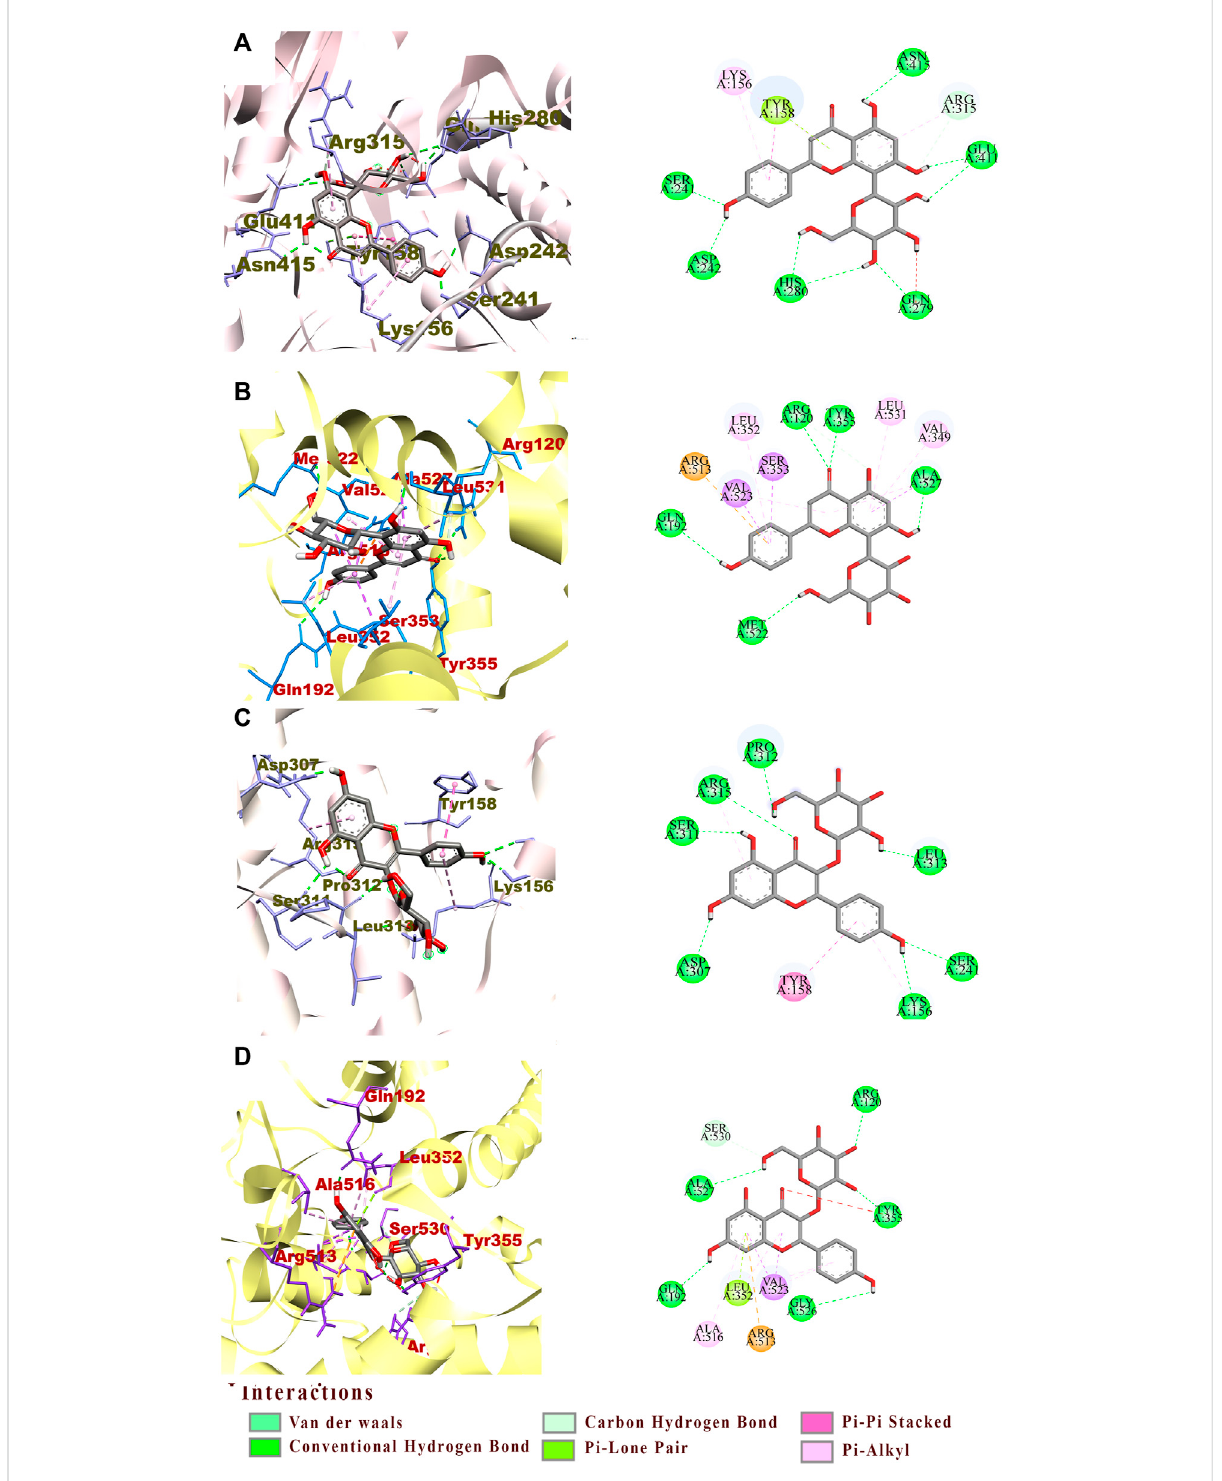
FIGURE 5 The interactions between active pocket of α -Glu (grey) or COX-2 (yellow) with vitexin (A,B) and astragalin (C,D) by molecular docking analysis. Thekeyinteractingaminoacidresiduesare:Serine(Ser),Glutamine(Gln),Arginine(Arg),Glutamicacid(Glu),Tyrosine(Tyr),Lysine(Lys),Asparticacid (Asp), Proline (Pro), Leucine (Leu), Valine (Val), and Glycine